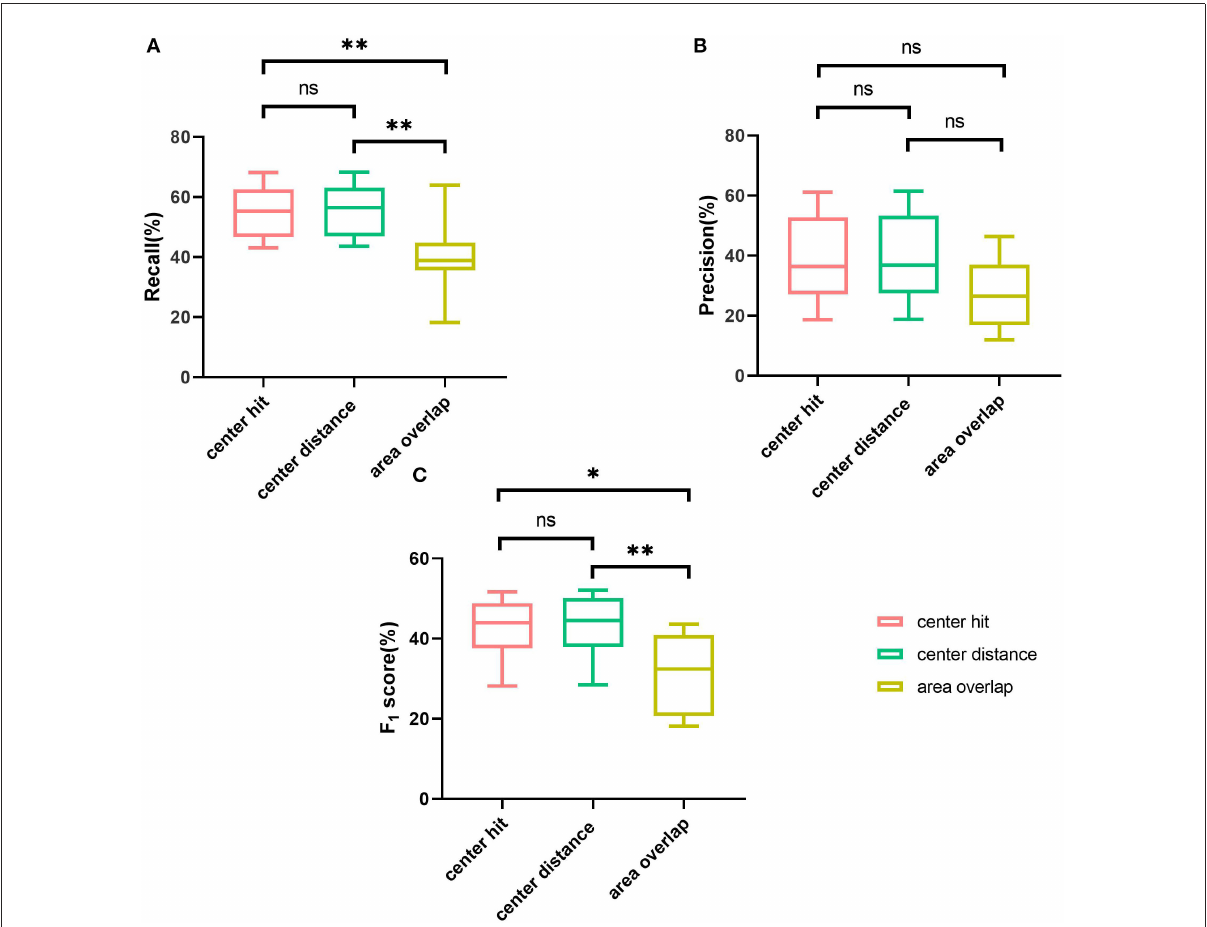
FIGURE4 Comparison of three mark-labeling methods by boxplot. (A) The boxplot showing the range of the recall of the AUTs according to three mark-labeling methods. (B) The boxplot showing the range of the precision of the AUTs according to three mark-labeling methods. (C) The boxplot showing the range of the F1 score of the AUTs according to three mark-labeling methods. Note: **means P value is no more than 0.01, *means P value is no more than 0.05, ns means P value is greater than